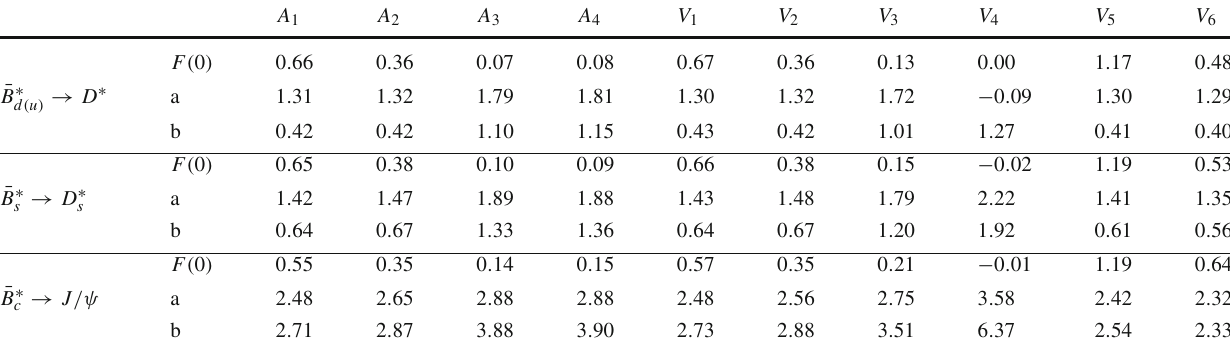
Table 3 The input parameters of the form factors for ¯ B ∗ → D ∗ , ¯ B ∗ s → D ∗ s and ¯ B ∗ c → J /ψ transitions within the CLFQM used in our numerical